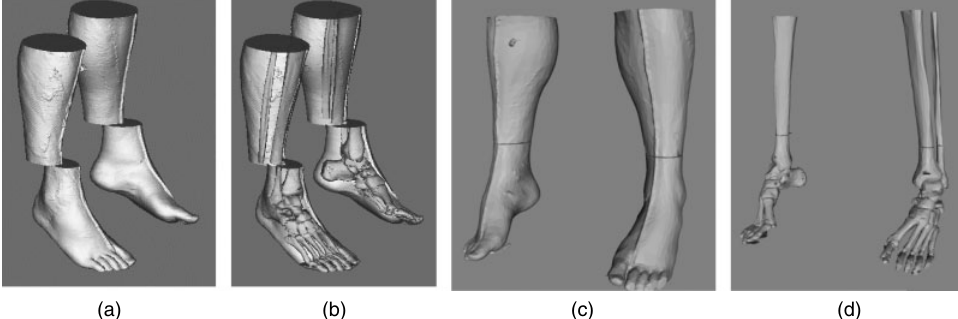
Figure 3 (a, b) 3D reconstruction of the Visible Human male CT data and (c, d) repaired 3D models, corrected for change of scanning